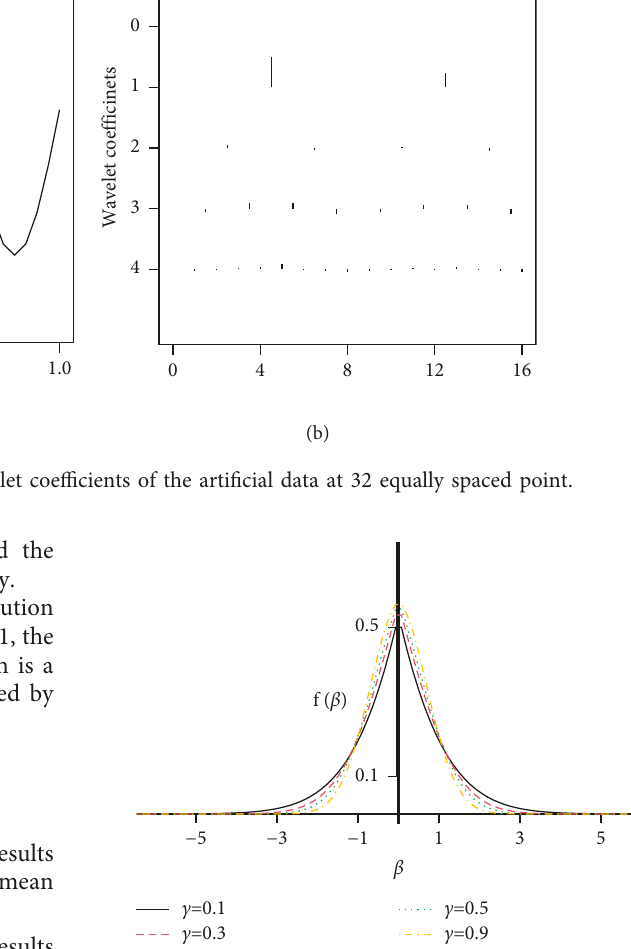
Figure 2: Plots of the standard elastic net with ζ � 1 and different values of c .